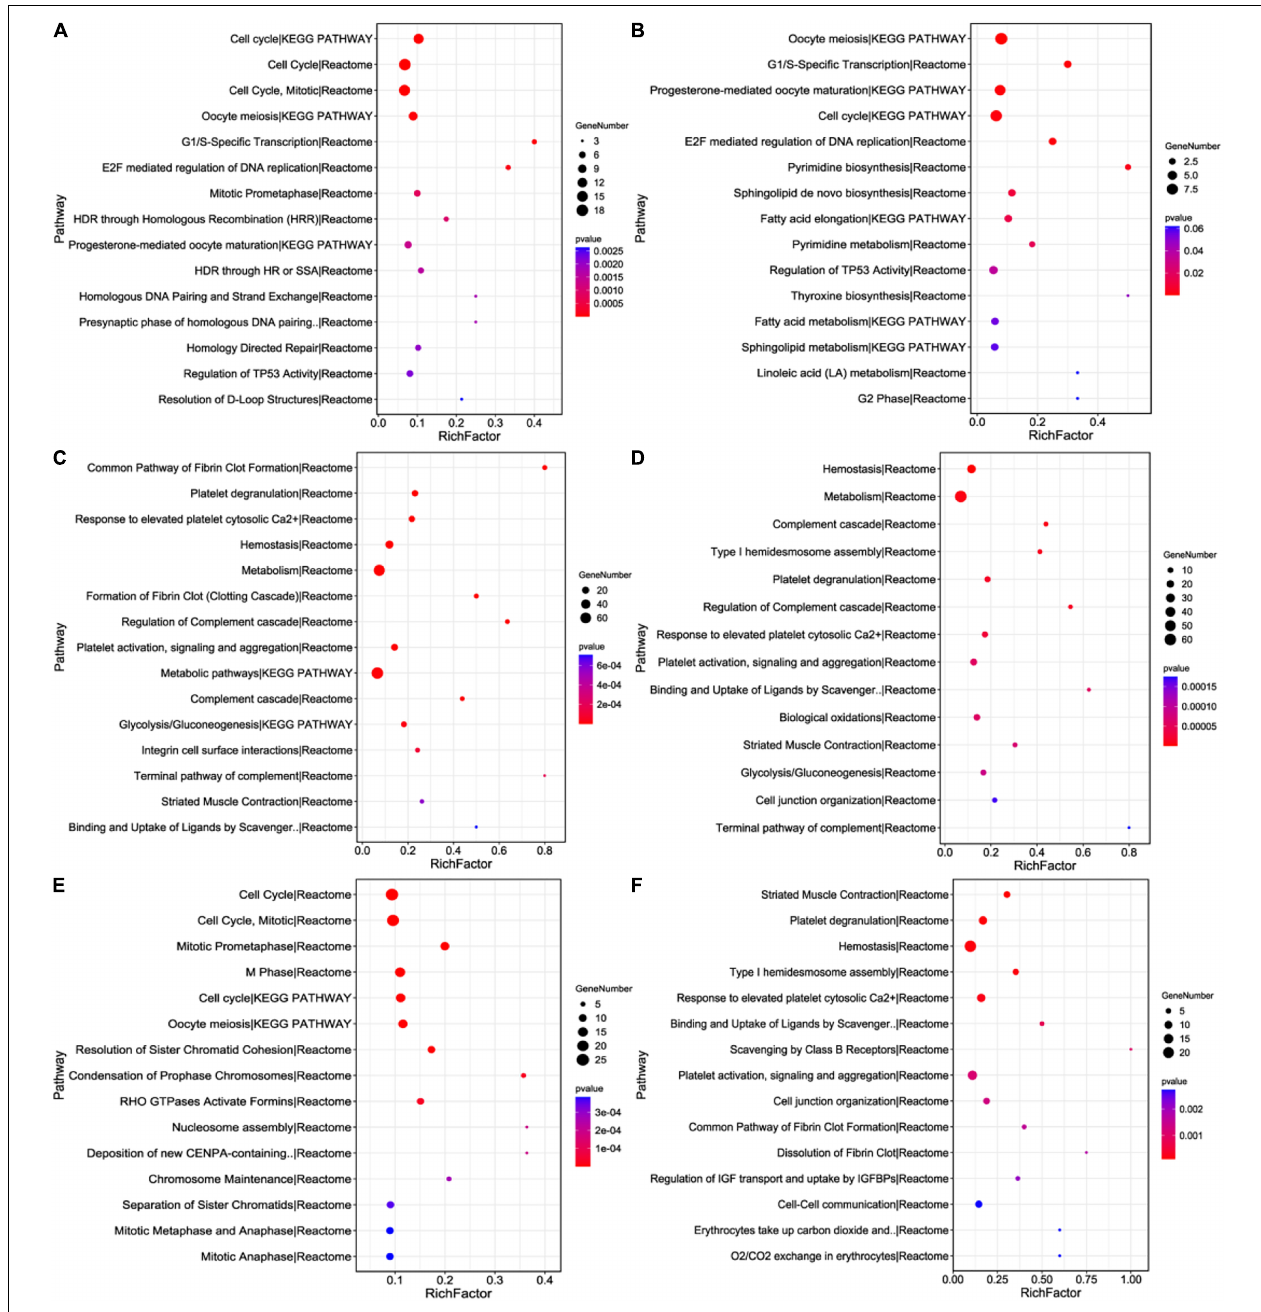
FIGURE 4 | Pathway enrichment analysis of DEGs via the KEGG, Reactome and Panther databases. The pathways were sorted by taking p -value < 0.05 as the threshold. The x-axis represents the rich factor, and the y-axis represents the pathway terms. The size of bubbles represents the number of enriched genes, and the color shows p -value. (A) 0.07 µ m MPs. (B) Cu-NPs + 0.07 µ m MPs. (C) 0.7 µ m MPs. (D) Cu-NPs + 0.7 µ m MPs. (E) 7 µ m MPs. (F) Cu-NPs + 7 µ m